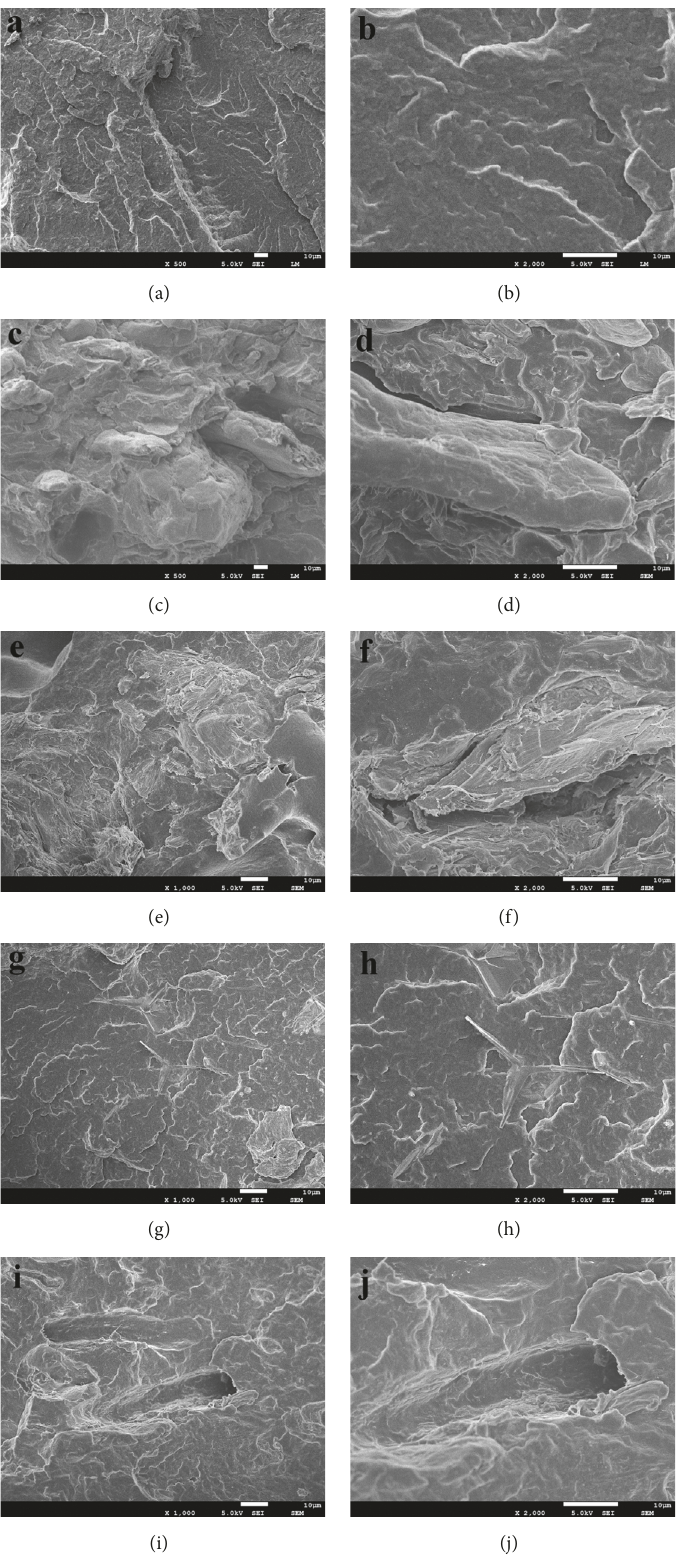
Figure 3:Fracturedsurfacemicrographs ofrPPand its composites:(a-b)PP-g-MA/rPP(5/95);(c-d)MCC/rPP(60/40)(500 × and2000 × );(e- f) MCC/PP-g-MA/rPP(60/5/35); (g-h) T-ZnOw/PP-g-MA/rPP(5/5/90); (i-j) T-ZnOw/MCC/PP-g-MA/rPP(5/55/5/35)(1000 × and 2000 ×